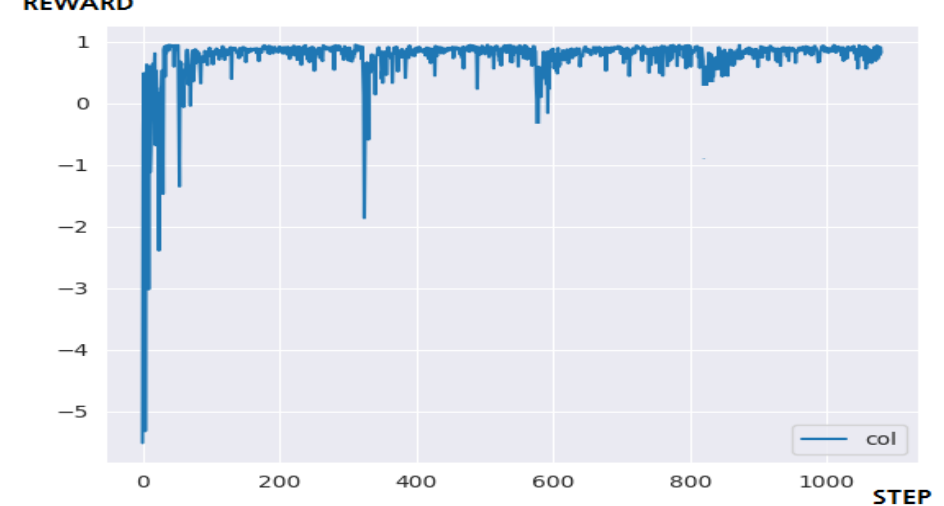
Figure 17. The result of the ping-pong game through N-DQN.